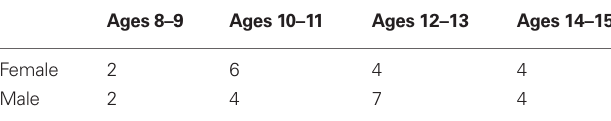
Table 1 | The distribution of ages and